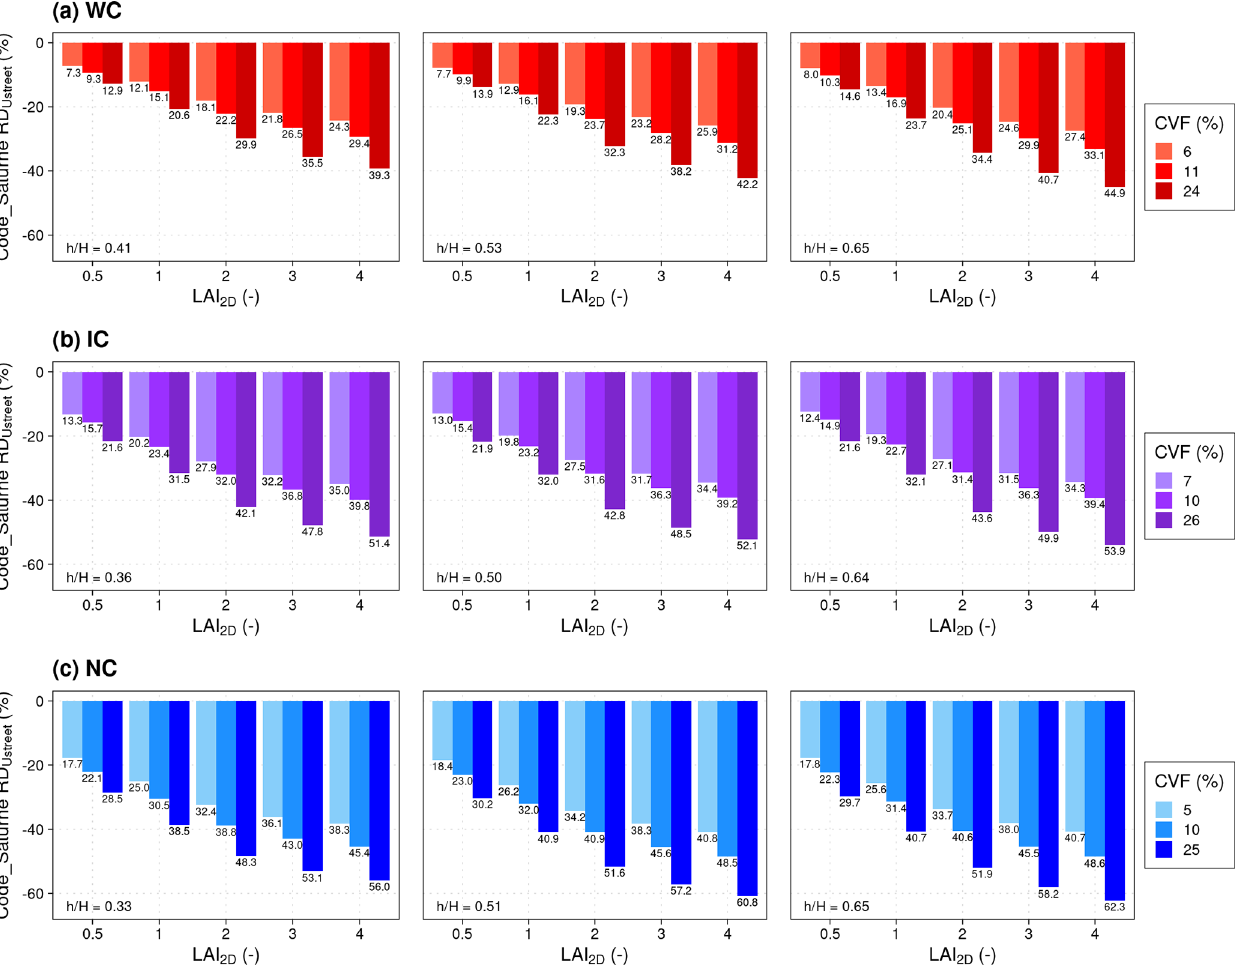
Figure 2. Relative deviation (RD) of U street computed from Code_Saturne simulations for different tree LAI 2D , CVF, and height ratio for WC (a) , IC (b) , and NC (c) . The graphic is divided into three columns corresponding to the three height ratios, and higher CVF correspond | values are specified with data to darker colors. | RD U street